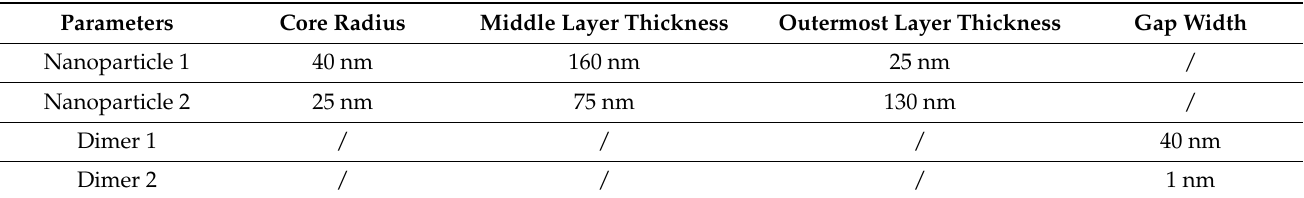
Table 1. Parameters of the components of the